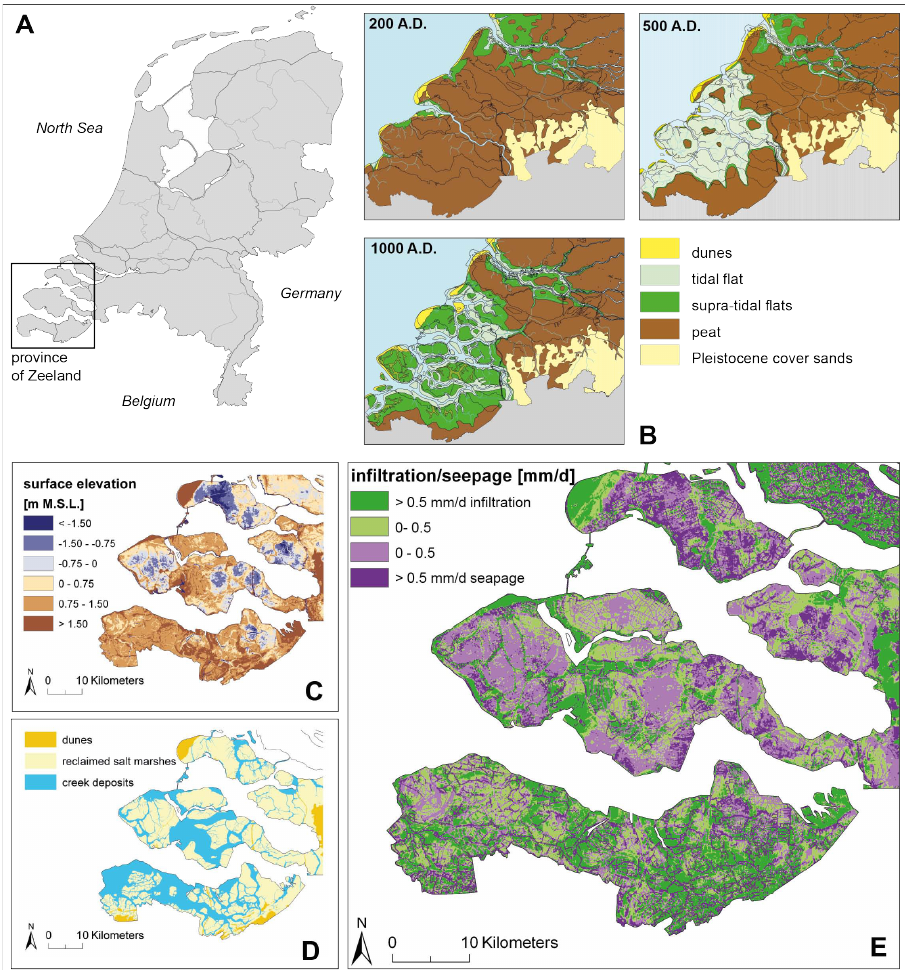
Fig. 2. (a) Location of study area. (b) Paleogeography of study area in 200AD, 500AD, 1000AD (Vos and Zeiler, 2008; by courtesy of Vos). (c) Surface elevation. (d) Position of the dunes, reclaimed salt marshes and sandy creek deposits (from: REGIS II, 2005). (e) Infiltration and seepage flux (result of regional groundwater model; van Baaren et al.,